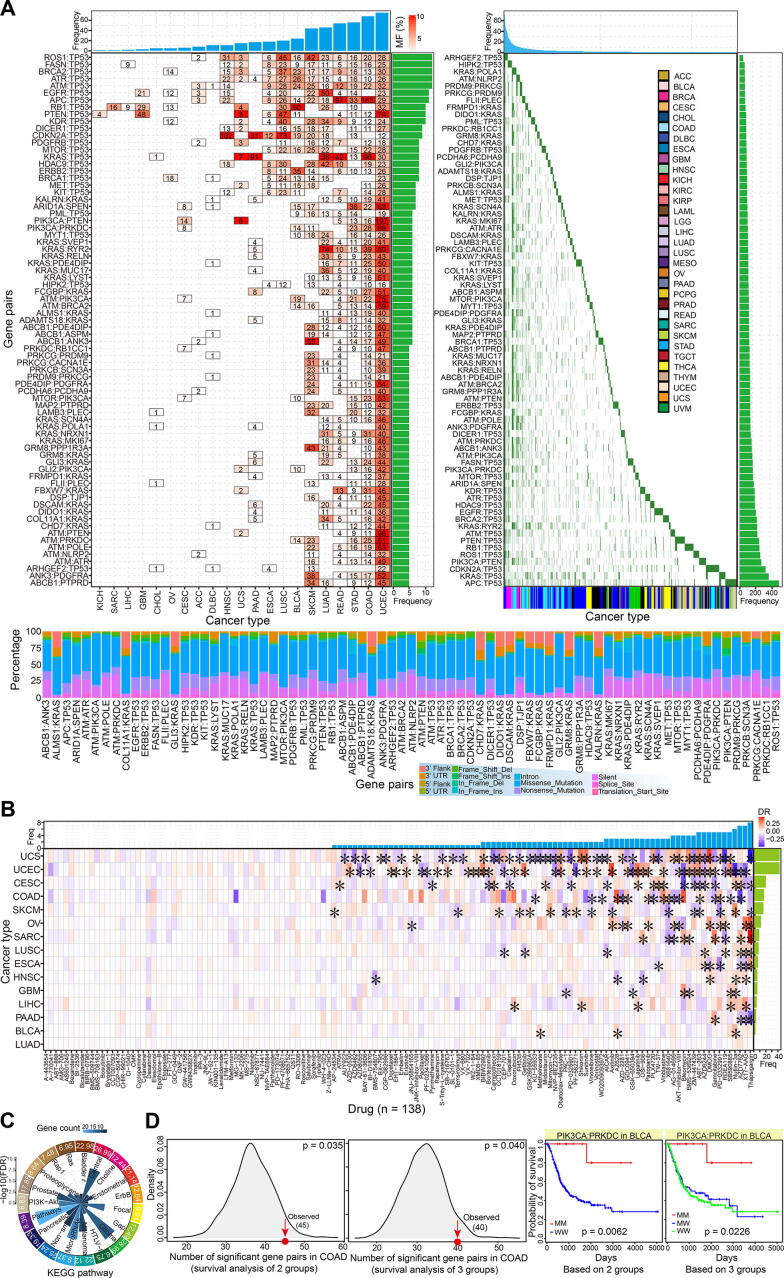
Analysis of synthetic lethal interactions at mutation level. A. Distribution of screened candidate 75 gene pairs based on mutation data (both two involved genes are detected mutation). These gene pairs are detected mutation in at least five cancer types (more than 2% total samples in each cancer type). The number shows frequency detected in samples. The right figure shows their distributions across patients. Below figure indicates percentage distribution of involved mutation type for each gene pair. B. Drug responses of gene pairs (based on grouping at mutation level, between group 1 and group 3) across cancer types. * indicates drug with significant statistical difference between gene pairs with double mutations and double wildtype groups (DR > 0.10 or DR < −0.10 and simultaneously p < 0.05 (FDR < 0.10)). C. Enriched biological KEGG pathways of involved genes (FDR < 0.05). Fold Enrichment values are presented in outer ring in white words. The detailed enriched significant KEGG pathways include: Bladder cancer, Central carbon metabolism in cancer, Choline metabolism in cancer, Endometrial cancer, ErbB signaling pathway, Focal adhesion, Gap junction, Glioma, HTLV-I infection, Melanoma, MicroRNAs in cancer, Non-small cell lung cancer, Pancreatic cancer, Pathways in cancer, PI3K-Akt signaling pathway, Prostate cancer, Proteoglycans in cancer, Rap1 signaling pathway, and Ras signaling pathway. D. Survival analysis of different groups based on the most dominant mutation type (missense mutation). The observed number of significant gene pairs is compared with a randomization test in COAD (1000 times). The empirical p-value based on the two groups is 0.035, and the empirical p-value based on the three groups is 0.04. An example shows probability of survival for PIK3CA:PRKDC gene pair in BLCA based on 2 (MM, n = 11; WW: n = 309) and 3 groups (MM, n = 11; MW: n = 91; WW: n = 309), respectively. MM: double mutations in candidate gene pair; MW: one mutation and another wildtype; WW: double wildtypes.